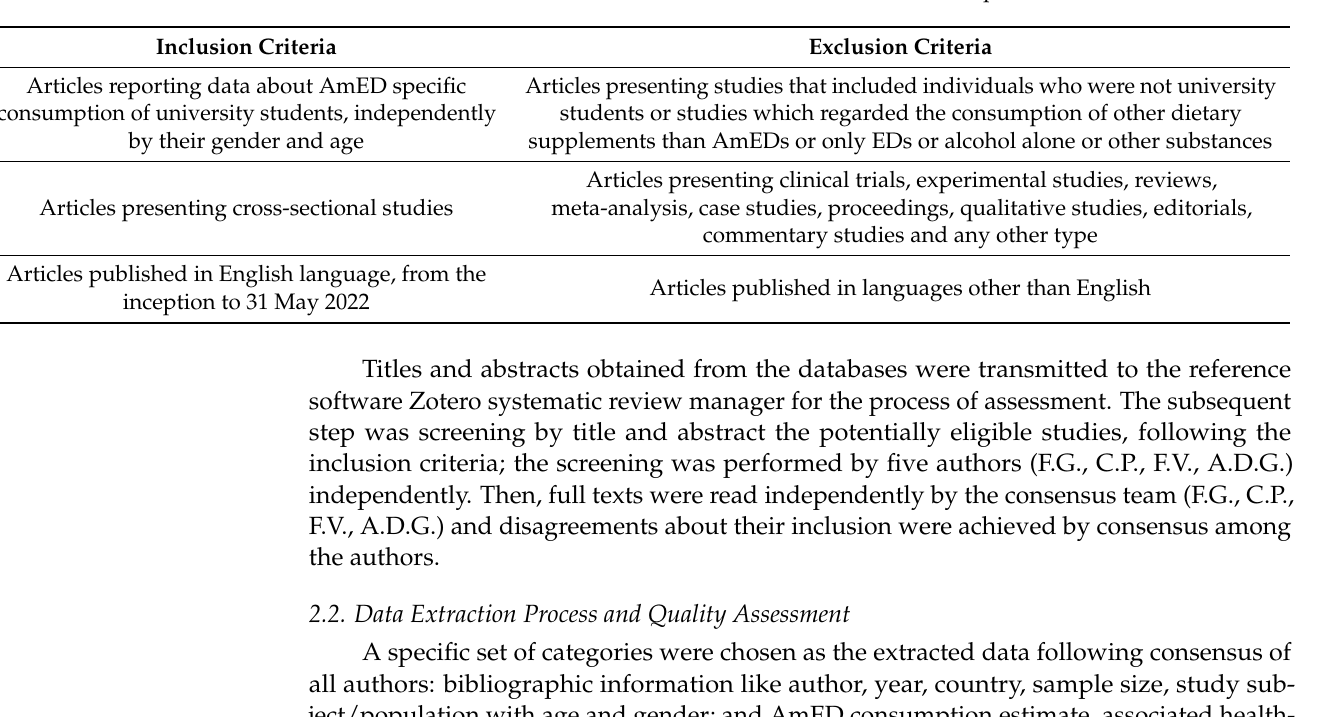
Table 2. Inclusion and exclusion criteria used in the article selection